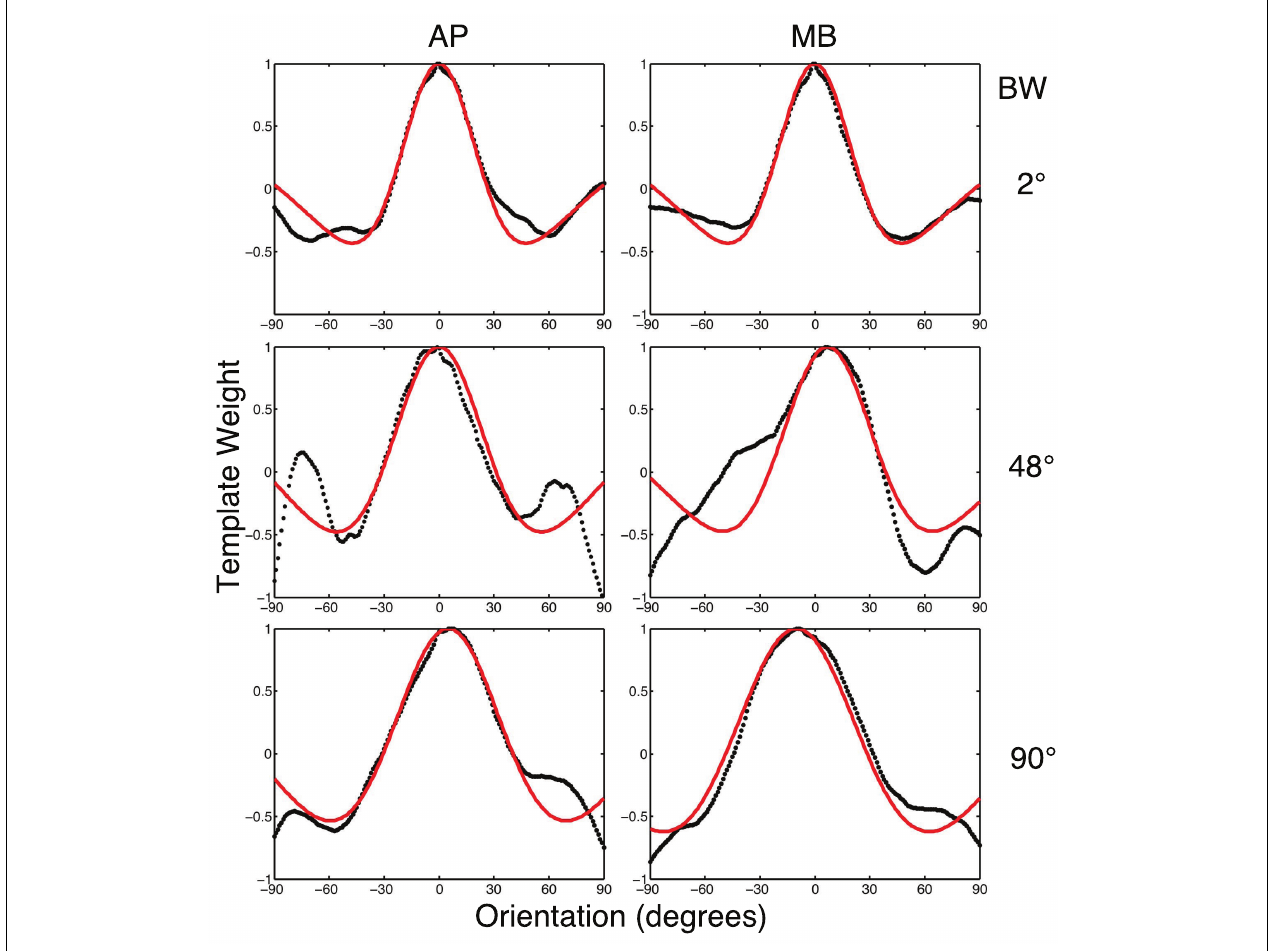
FIGURE 6 | The black dotted lines show the one-dimensional circularly summed classification images for two observers in three conditions. The red lines show the best difference of Gaussian fits to the empirical data. The x -axis in each sub-figure is orientation, the y -axis the weight of the classification